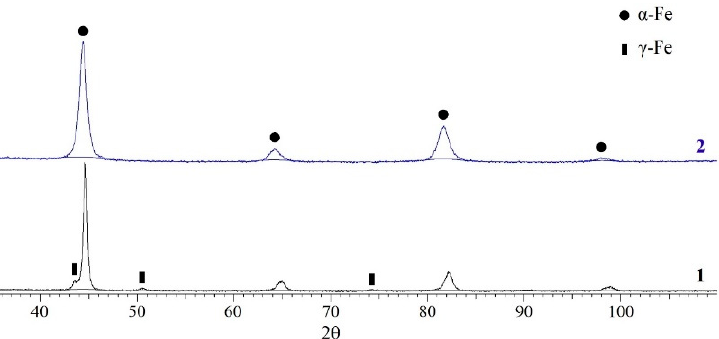
Figure 7. XRD of L-DED samples in the perpendicular ( 1 ) and longitudinal ( 2 ) directions without US-assisted treatment.